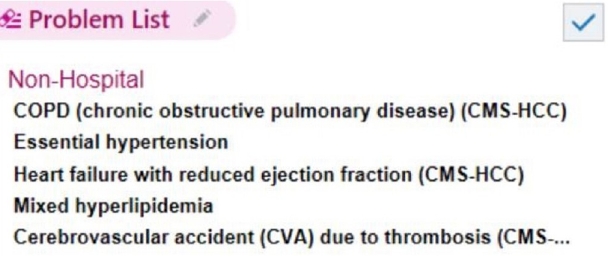
Fig 1. Depiction of the electronic health record-based problem list. Used with permission of 2021 Epic Systems